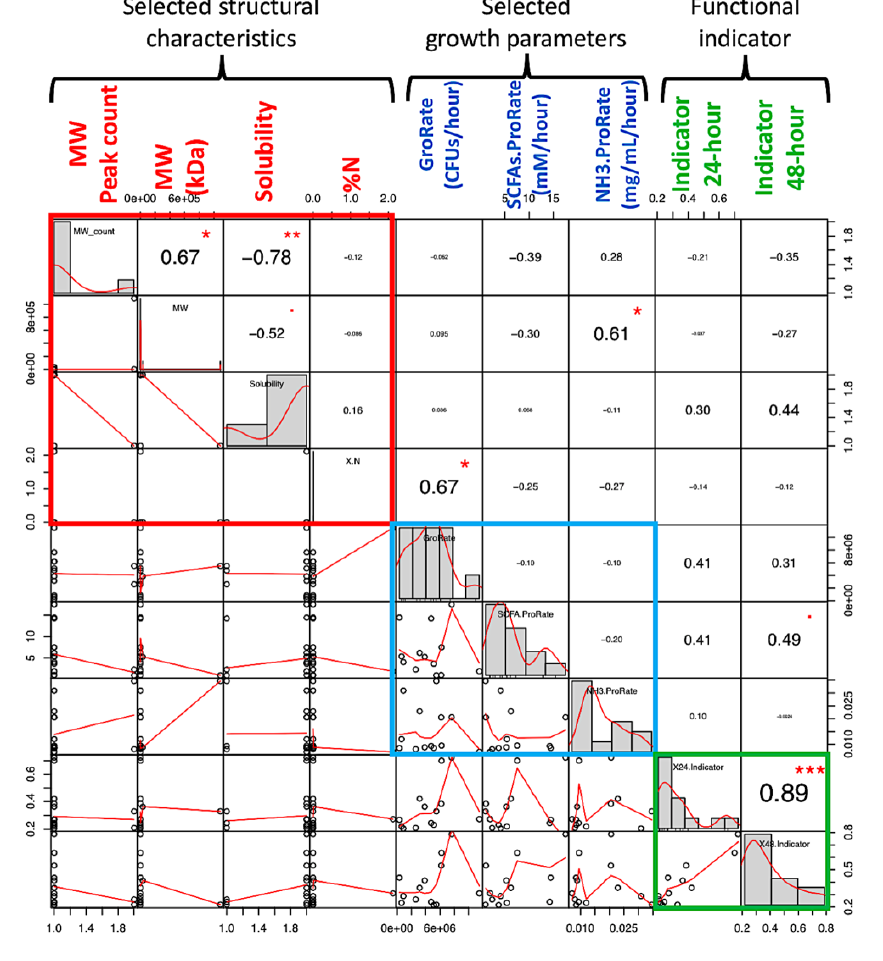
Figure 7. Exemplified selected structure characteristics, selected parameters, and functional indicator correlation analysis. Pearson’s correlation was performed. Selected structural characteristics include molecular weight peak count, molecular weight of first peak, solubility by visual inspection, and % nitrogen (N) as impurities. Selected parameters included GroRate and ProRate of total SCFAs and dissolved ammonia. Functional indicator (SCFAs / NH 3 ) at both 24 and 48 h were also included. Significant correlation between structure and parameters were found to be (1) maximum total microbial population increase rate positively correlates with % nitrogen, and (2) dissolved ammonia production rate positively correlates with molecular weight. “ * ” denotes p -value <0.05; “ *** ” denotes p -value <0.001.